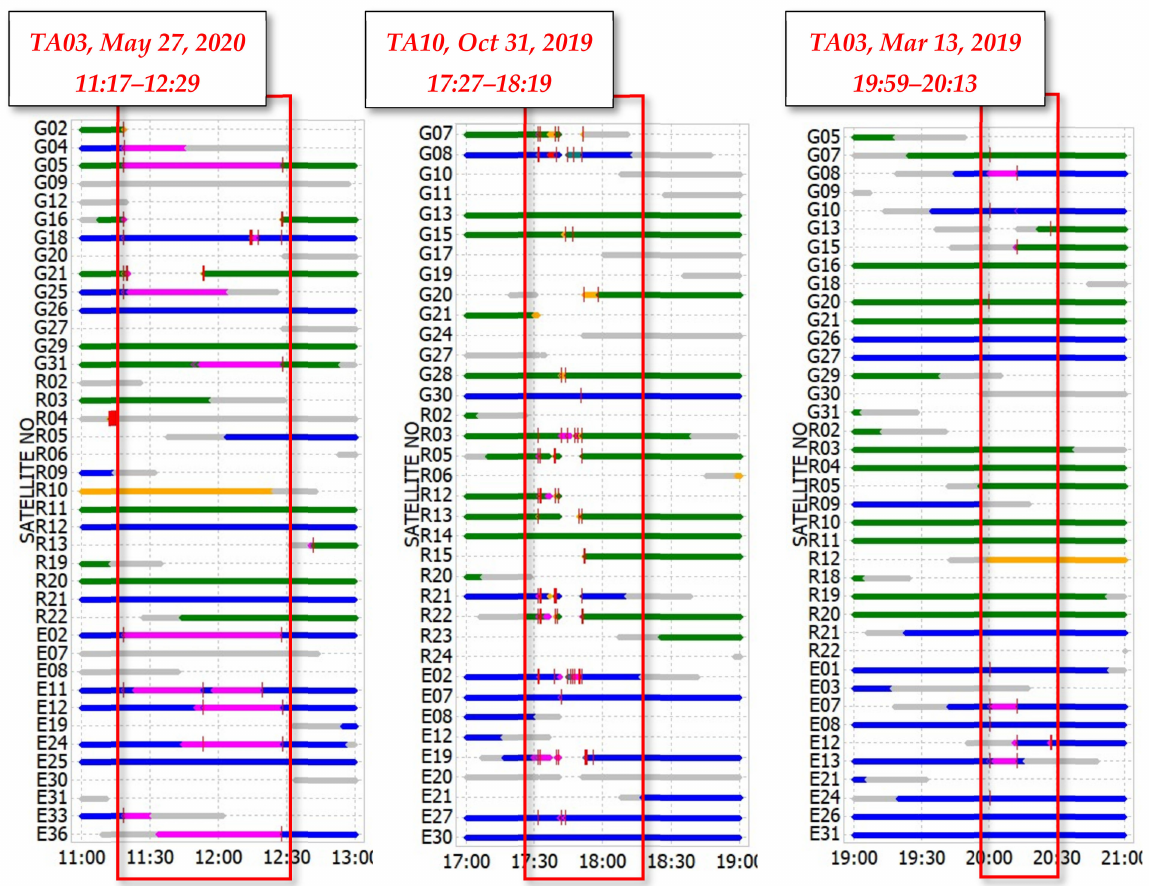
Figure 7. Signal tracking and cycle slips (marked in red) for all three cases. From the left, Case 1, Case 2, and Case 3 on the far right. The red boxes mark the jamming incident, with approximate times displayed at the top. Color coding of the tracking lines indicates available signals: Green = L1 + L2, Blue = L1 + L2 + L5, Yellow = L1 only, Pink = L2